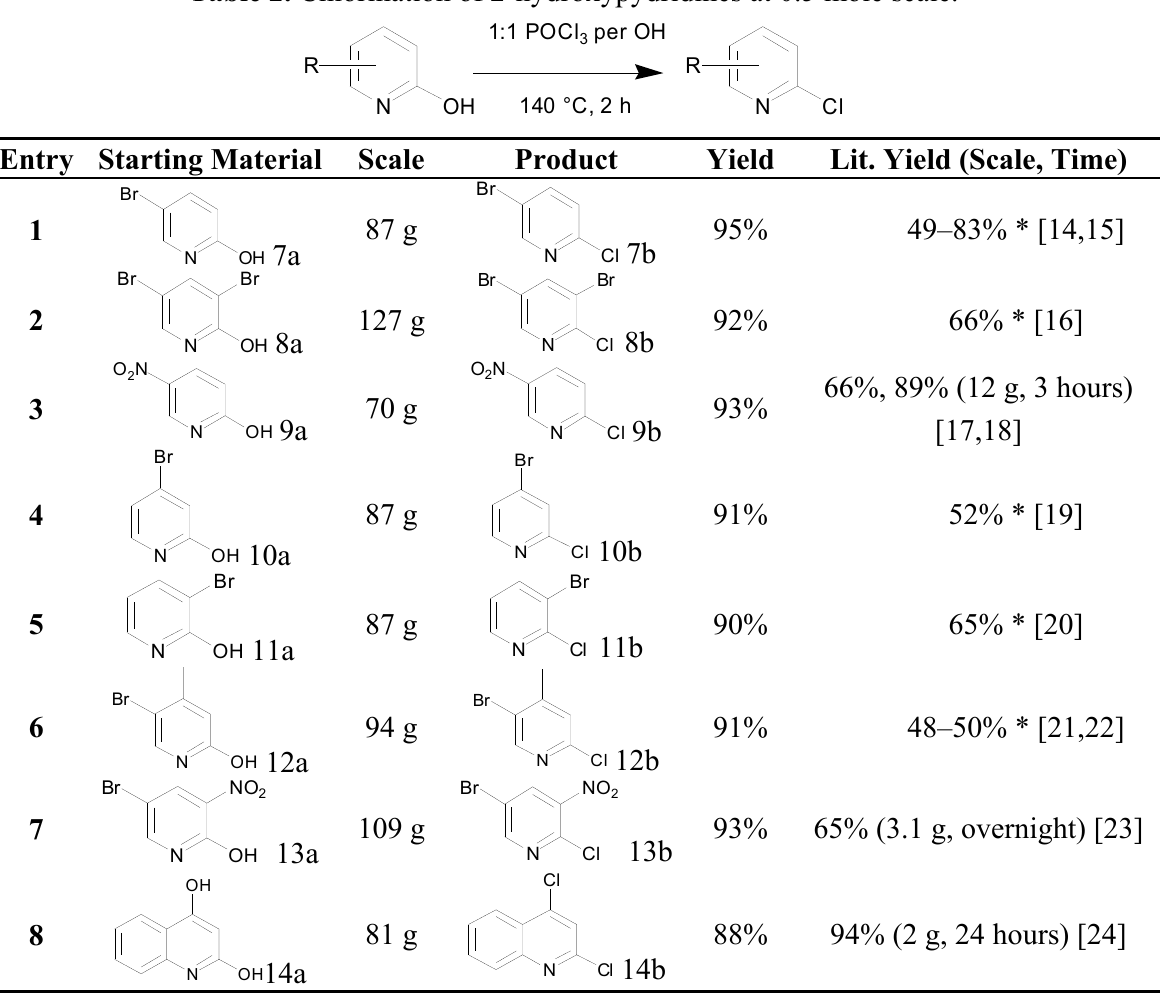
Table 2. Chlorination of 2-hydroxypydridines at 0.5 mole